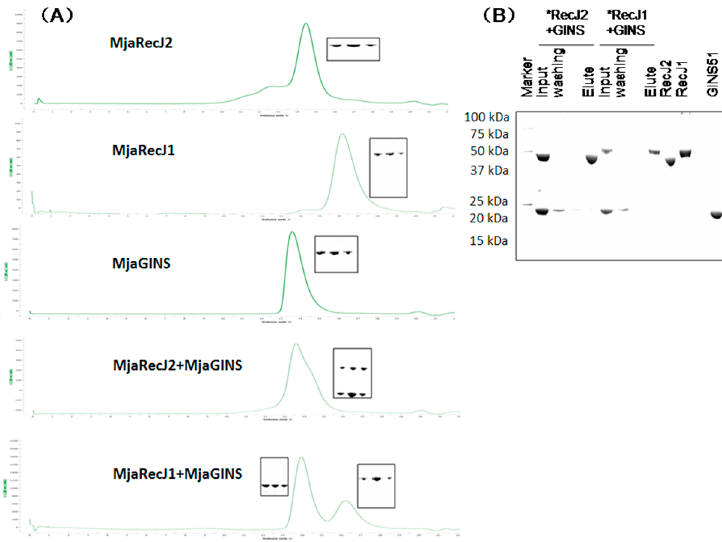
Figure 8 . Methanocaldococcus jannaschii GINS does not interact with any of MjaRecJs. ( A ) Gel filtration was used to characterize the existence of complexes between MjaGINS51 and MjaRecJ1 or MjaRecJ2. Each peak was collected for protein identification by sodium dodecyl sulfate polyacrylamide gel electropheresis (SDS-PAGE). ( B ) The pulldown experiments were used to characterize the interaction between M. jannaschii GINS and RecJ1 or RecJ2. 6×Histine-Tag RecJs were co-purified with the no His-Tag GINS using a Ni-NTA Resin. His-Tag MjaRecJ1 or MjaRecJ2 was mixed with MjaGINS (His-Tag free) in a molecular ratio of 1:2. After binding and washing, and resins were eluted with buffer containing 200 mM imidazole. Protein(s) in elutes were verified by 15% SDS-PAGE.